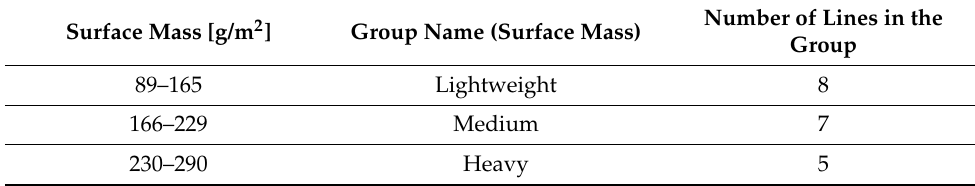
Table 5. TSLs population, divided into groups based on their substrate weave.